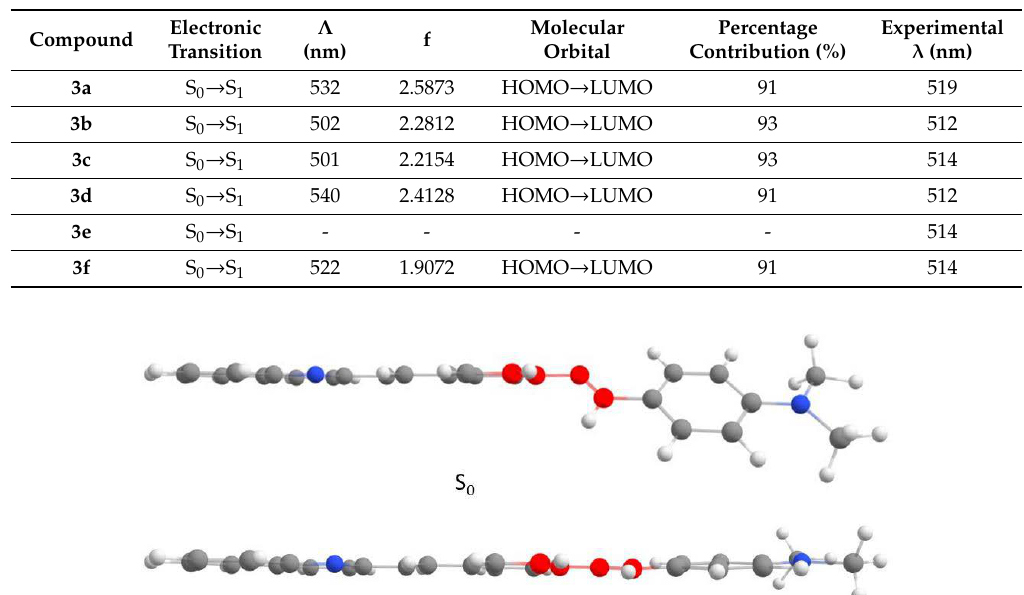
Figure 7. Visualization of the molecular orbitals that were involved in the main electronic transitions. Table 6. Emission data obtained for 3a – f by TD–DFT // B3LYP // 6-311 + G (d), using a PCM model (ethanol).